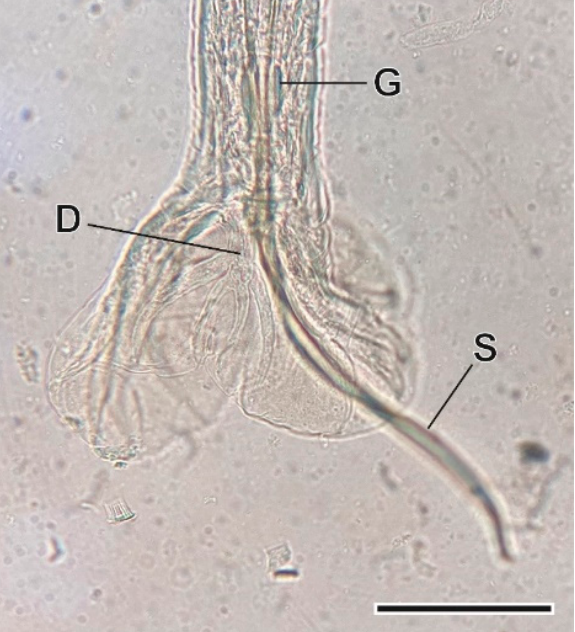
Figure 7. Caudal bursa of a Carolinensis minutus male. D, dorsal ray; G, gubernaculum; S, spicules. Scale bar = 1 µm.